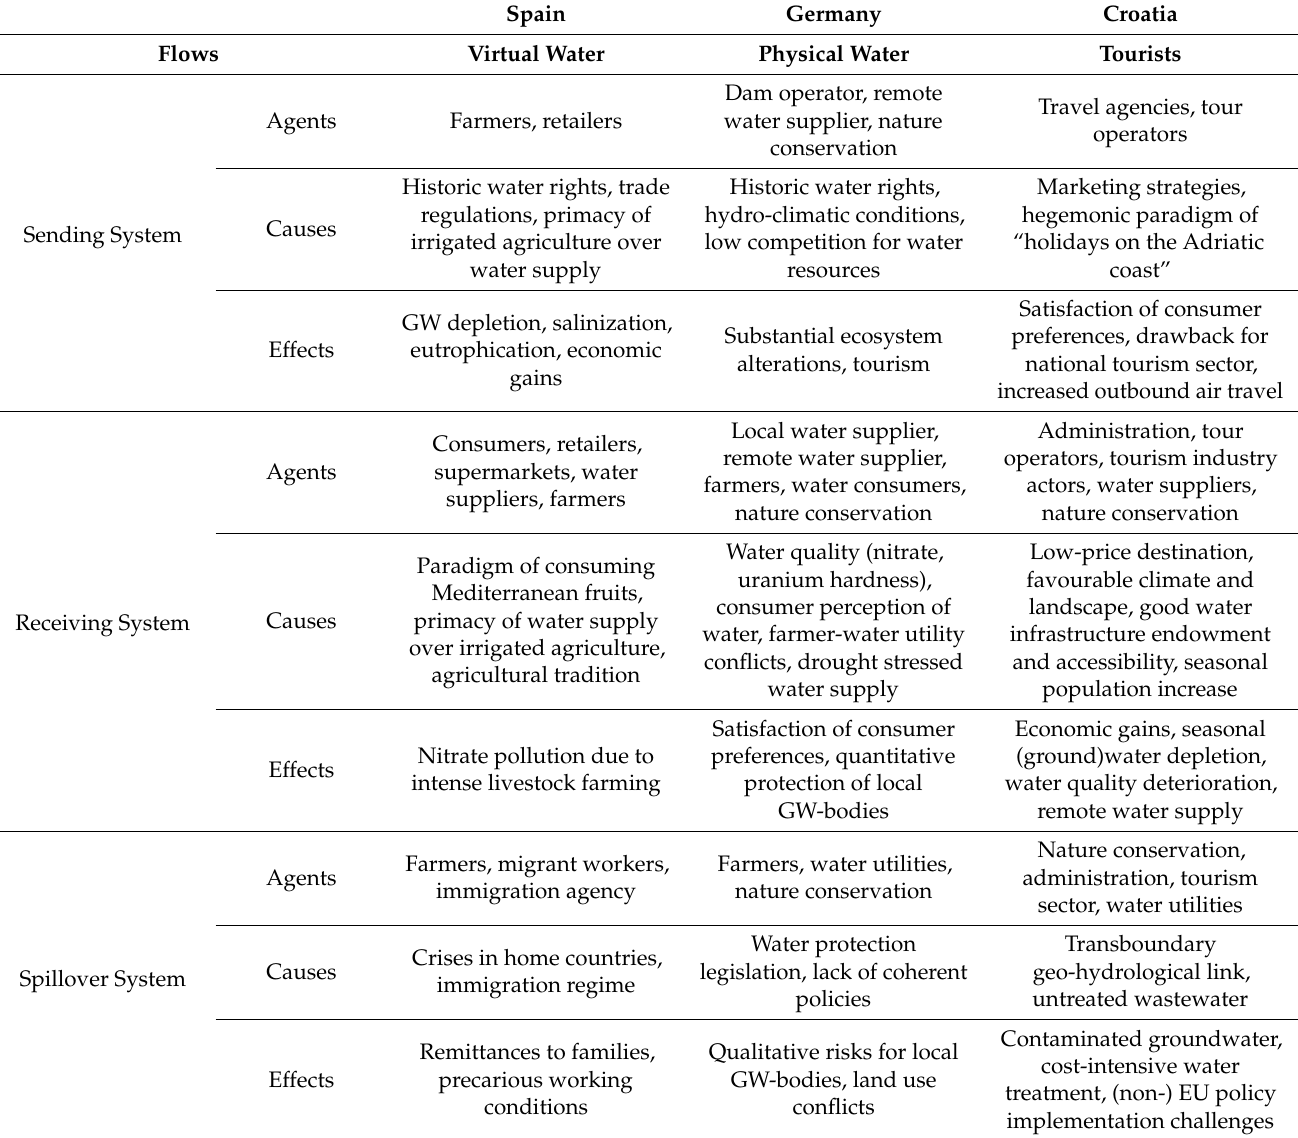
Table 1. Comparative overview on exemplary telecoupling cases in Europe. Sections 3.1–3.3 give more detailed case